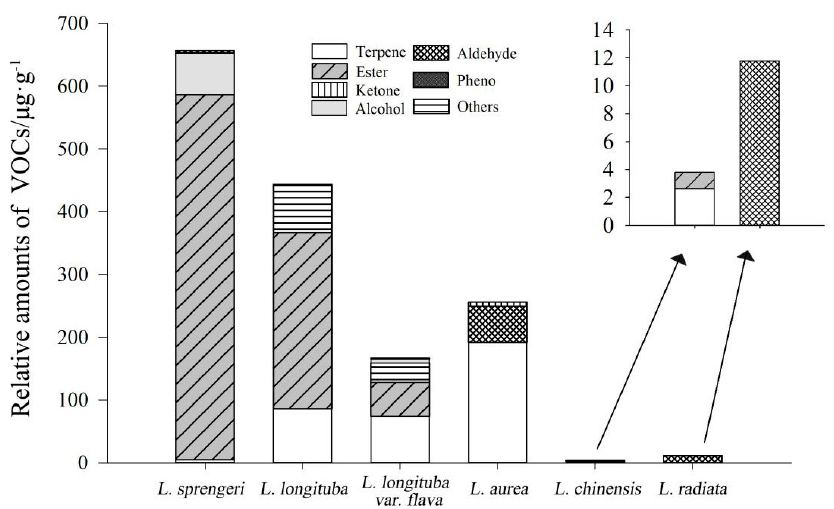
Figure 2. The content of various classes of aromatic compounds in six Lycoris taxa. Aromatic compounds mainly include terpenoids, alcohols, esters, aldehydes, ketones, and phenols.